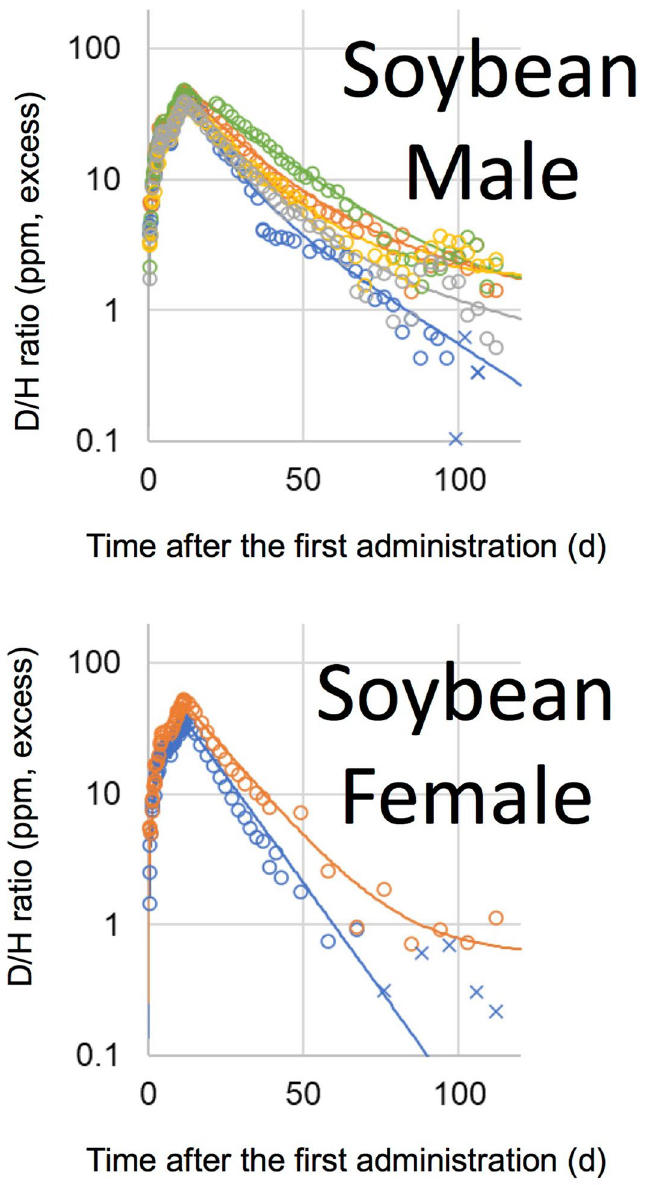
Figure 4. D/H ratios in urine, after oral administration of D-labelled soybean for 2 weeks, except for Saturday and Sunday. The ratio was normalized to the same dosage per body weight (1 g D per 70 kg). Lines were fitted using models shown in Fig. 1. Data below the 90% upper confidence limit of the background fluctuation for each volunteer, and the subsequent data after elimination from the fit, are shown by crosses. Each colour represents a different